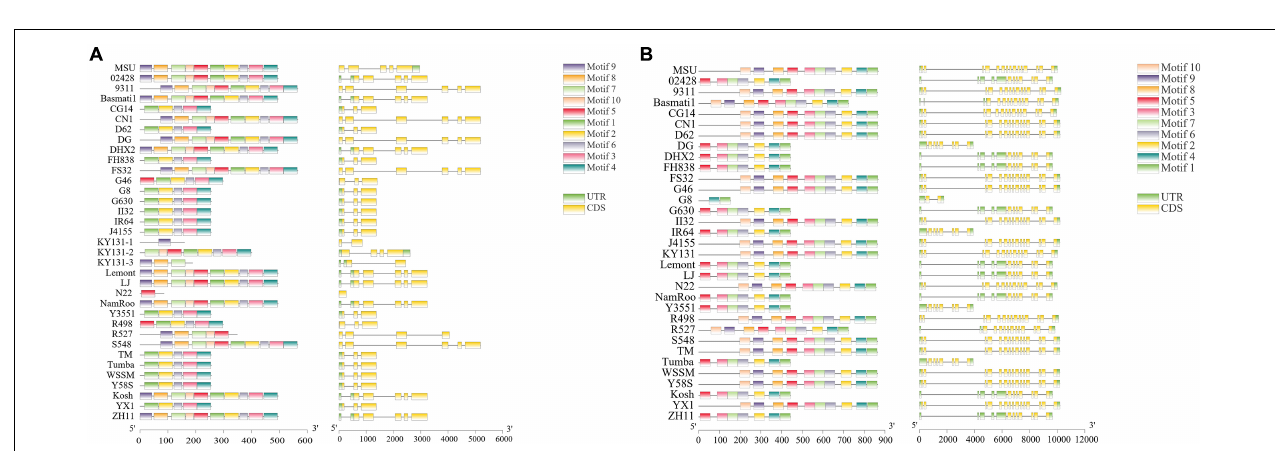
FIGURE 3 | SVs and CNVs overlapping with the TPS gene family. (A) The display of SV insertion or deletion 2 kb upstream or downstream of TPS genes. (B) SV insertion or deletion significantly altered some of the TPS s expression in roots or shoots (** p < 0.01 and *** p < 0.001, student’s t -test). (C) Schematic diagram of the occurrence of CNVs that significantly altered TPS expression. (D) Pie chart showing the proportion of SVs or CNVs that significantly altered TPS expression levels take up total SVs or CNVs that overlapped with the TPS gene family.